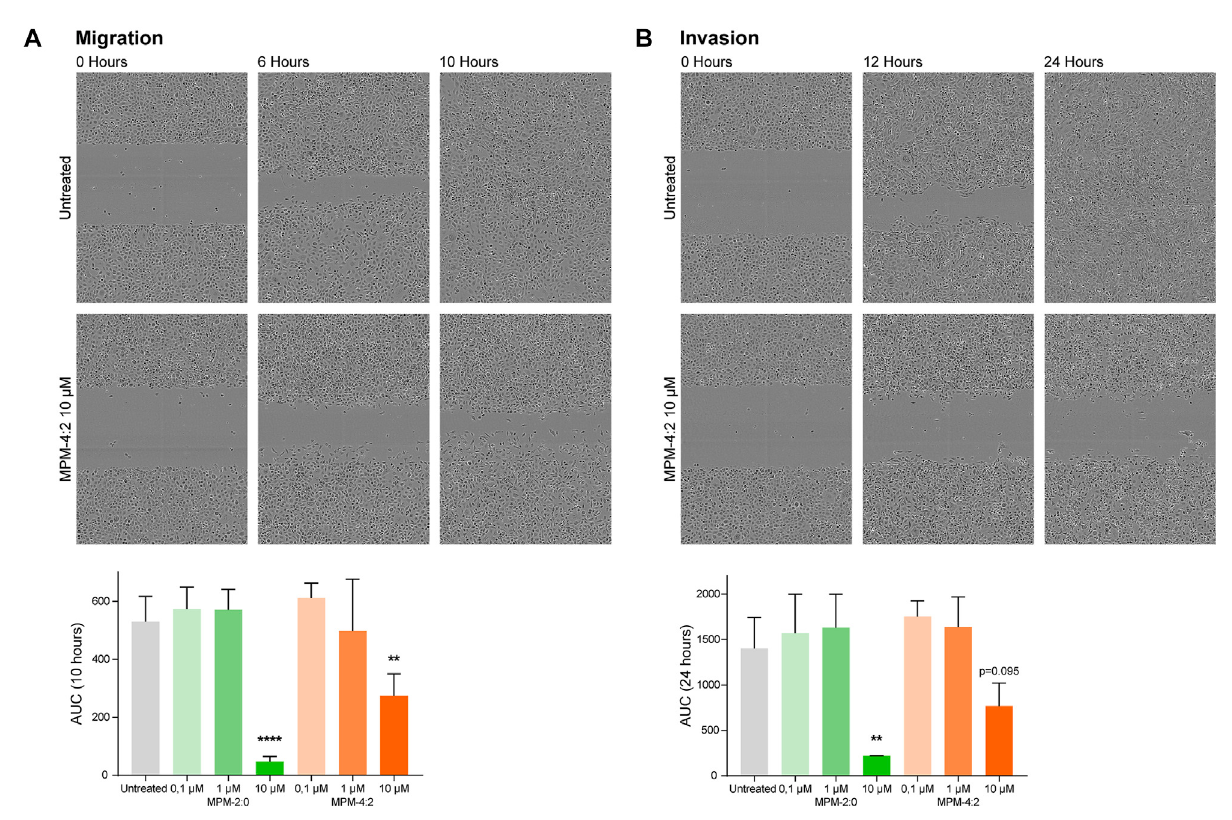
FIGURE 6 The migration and invasion of MPM treated HSC-3 cells was analyzed through scratch wound assays. The cells were left untreated or were treated with0.1,1or10 μ MofMPM-2:0orMPM-4:2.Inthemigrationassay (A) ,thewellswereonly fi lledwithmedia,andintheinvasionassay (B) ,thescratchwas fi lled with a myogel-collagen mix before the addition of media. The cells were imaged every 2 hours for 24 h. The results were quanti fi ed by calculating theareaunderthecurve(AUC)fortherelativewounddensityandstatisticaldifferenceswerecalculatedbyone-wayANOVAandDunnet ’ s posthoc . Four independent migration assays and three independent invasion assays were